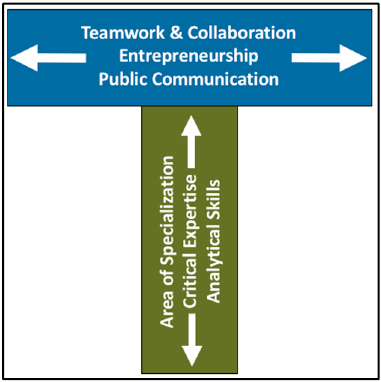
Figure 2. T-training results in a broad skillset [3]. In most graduate programs, disciplinary skills listed in the stem of the letter ‘T’ constitute the full training regime (green). For P3, cross-cutting skills matching the horizontal box are also developed (blue).